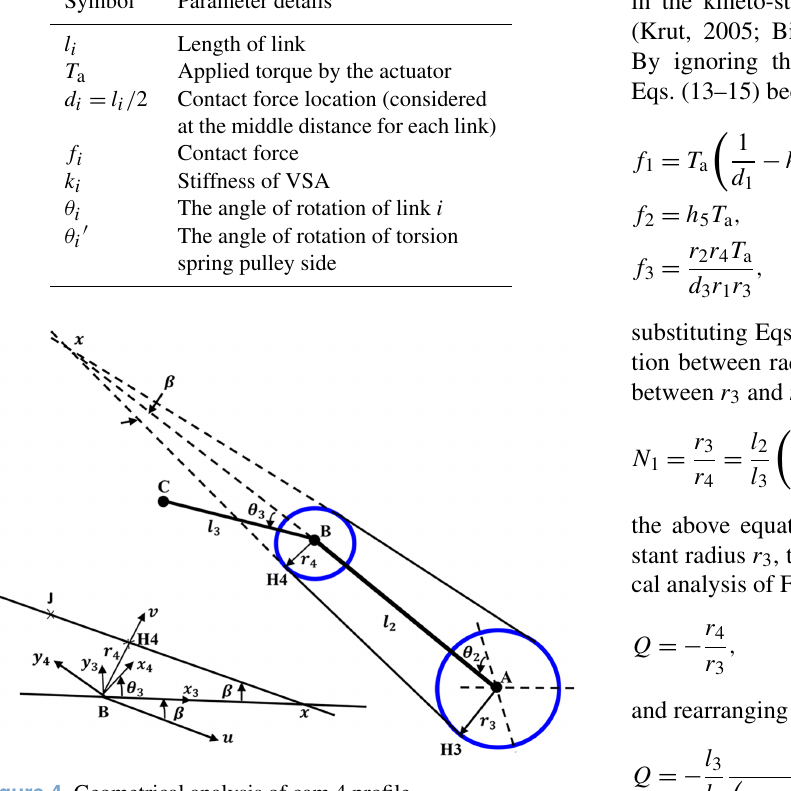
Figure 4. Geometrical analysis of cam 4